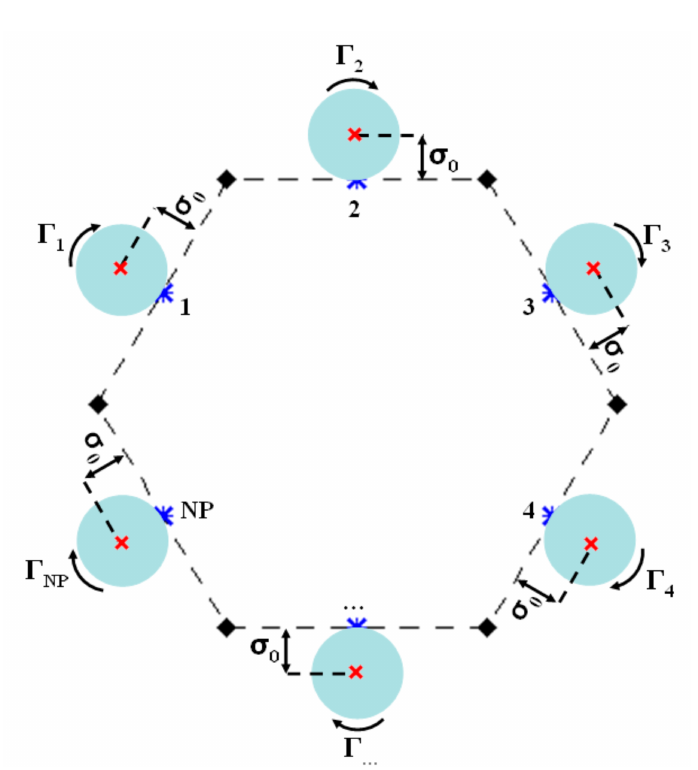
Figure 3. The boundary layer model for a smooth